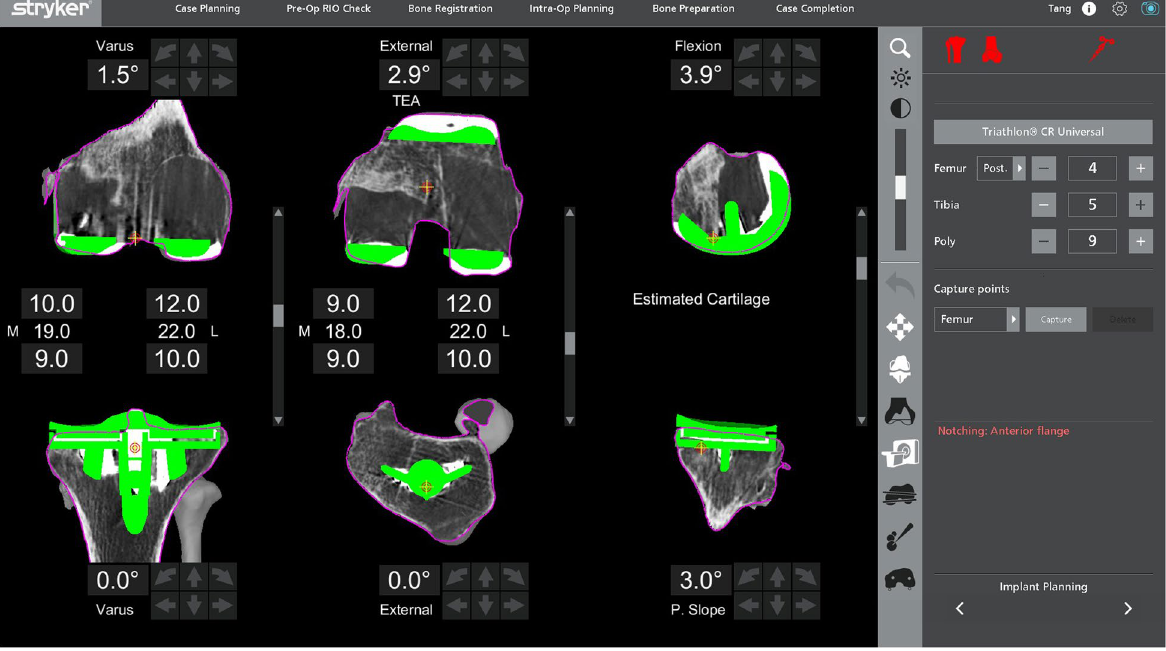
Fig. 8 Preoperative planning of a patient with massive bone cyst involving both femoral